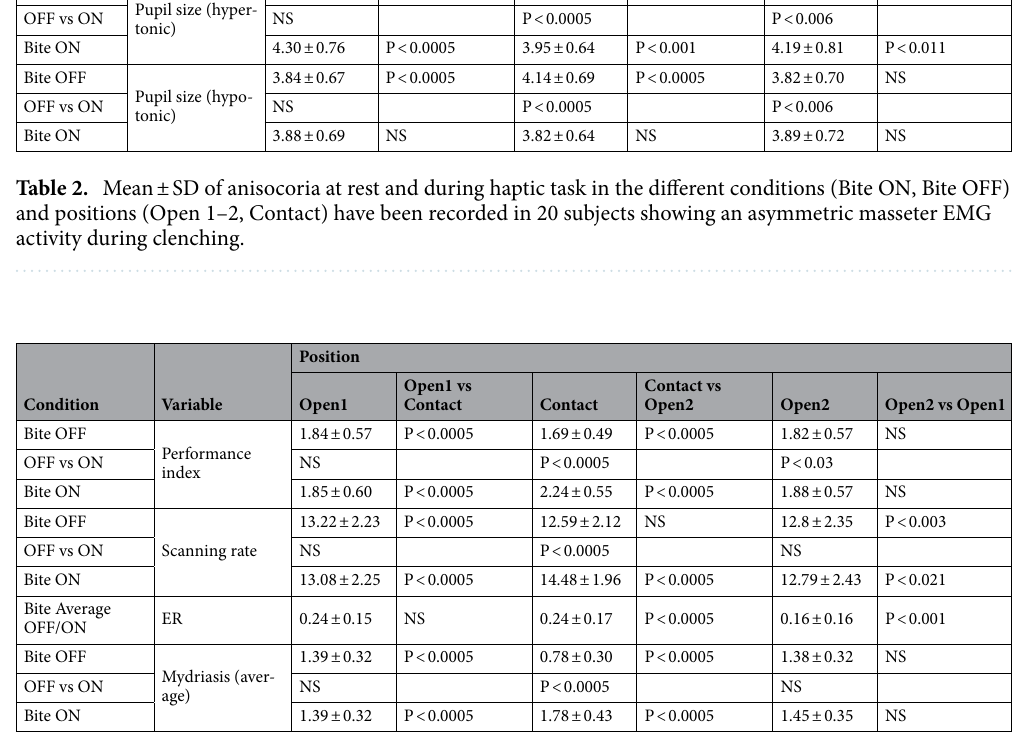
Table 3. Mean ± SD values of the different parameters characterizing the performance of the subject, recorded with and without Bite correction, in the open and contact position. PI performance index, SR scanning rate, ER error